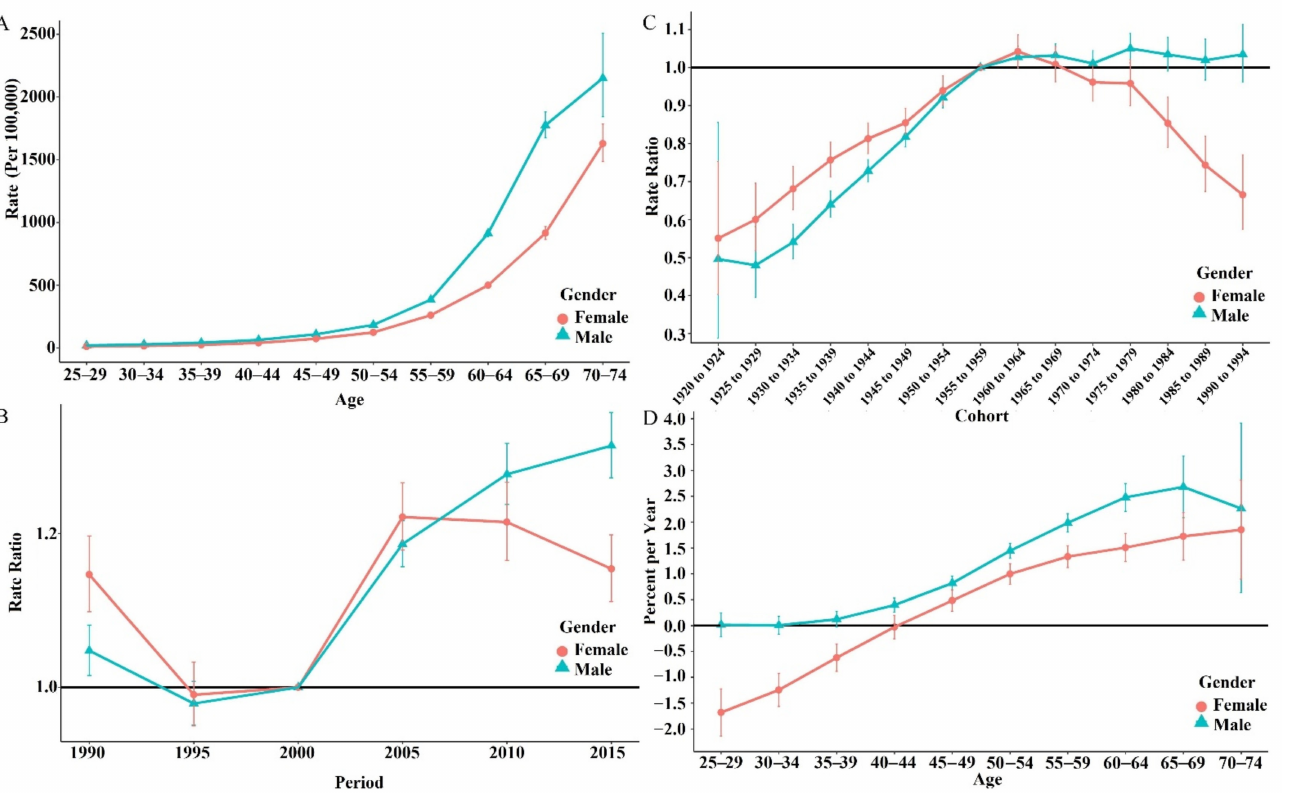
Figure 2. Effect of age, year period, and birth cohort and estimation of local drifts by genders. ( A ): Crude mortality rates (per 100,000) and corresponding 95% CI (the error bars) along age groups; ( B ): rate ratio (RR) and 95% CI (the error bars) for cohort effect; ( C ): RRs and 95% CI (the error bars) for period effect; ( D ): local drift (percent per year) along with age groups.